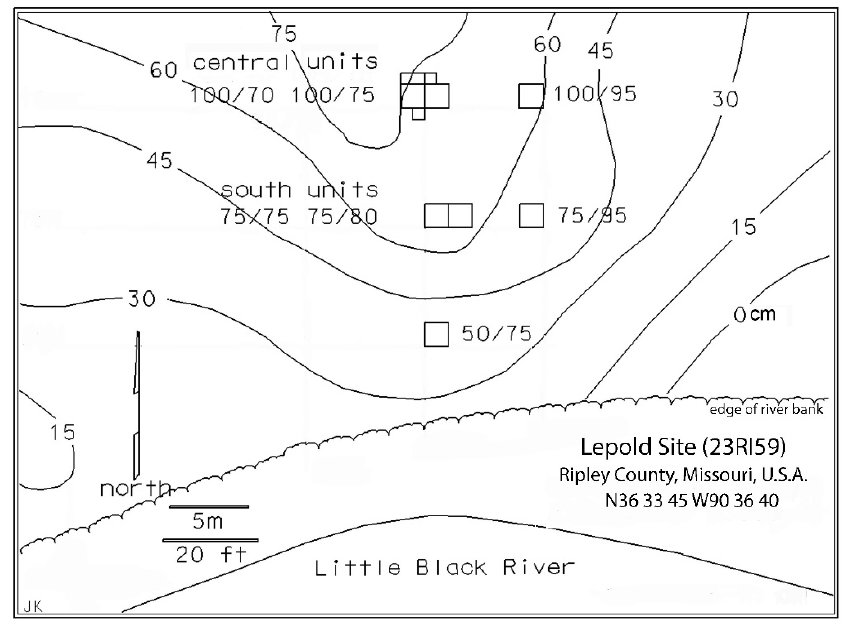
Figure 2. Excavation plan of Lepold site.